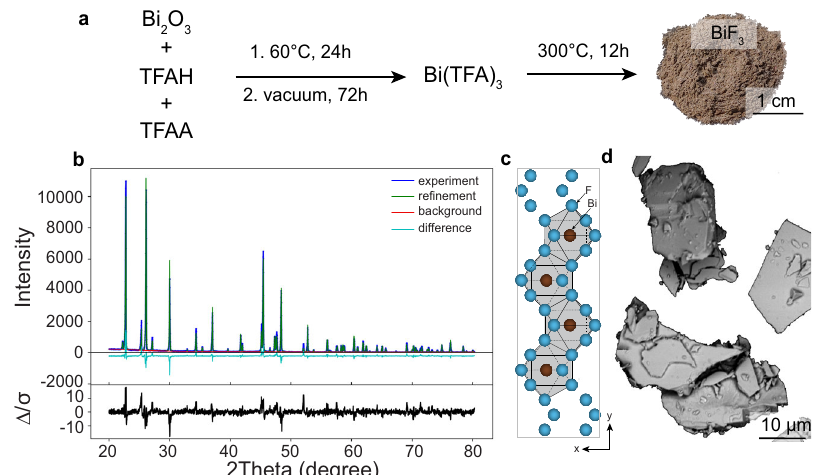
Fig. 2 Synthesis and characterization of BiF 3 . a Schematic of the BiF 3 synthesis (tri fl uoroacetic acid and tri fl uoroacetic anhydride are named as TFAA and TFAH, respectively); b A comparison of the experimental (blue) and calculated (green) powder diffraction pattern of BiF 3 together with the difference (cyan) and the background (red), as obtained from the Rietveld re fi nement with GSAS-II 43 . c Orthorhombic structure of BiF 3 . d SEM image of the BiF 3 particles.